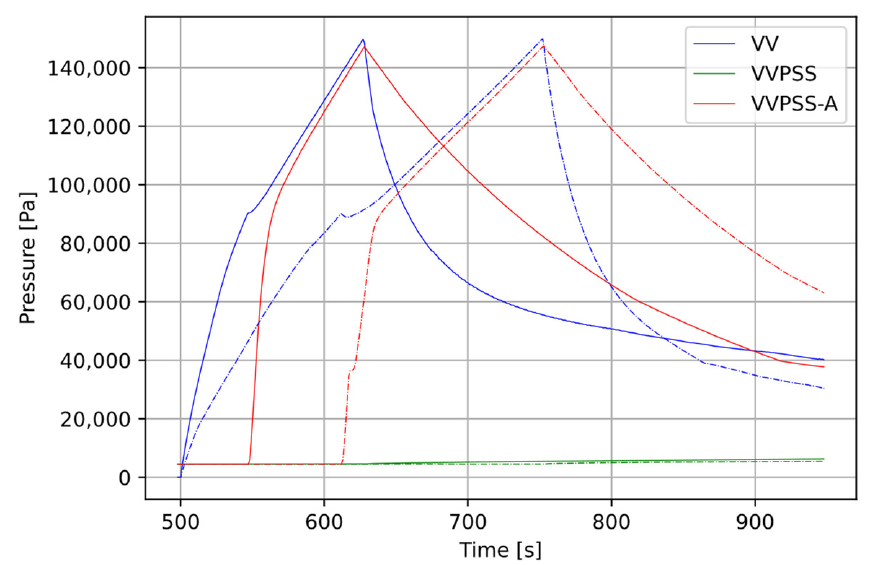
Figure 13. Pressure transient in VV and pressure-suppression volumes in PIE1 (dashed line) and PIE2 cases.